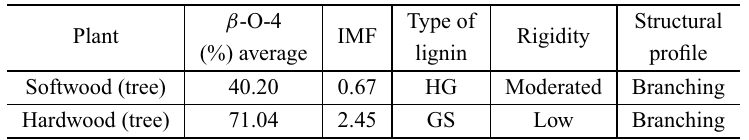
IFM estimated values of Björkman lignins from softwood and hardwood (Abreu et al. 1999). β -O-4 Structural Type of Plant IMF Rigidity (%) average lignin profile Softwood (tree) 40.20 Branching Hardwood (tree) 71.04 Branching IFM – Index of Molecular